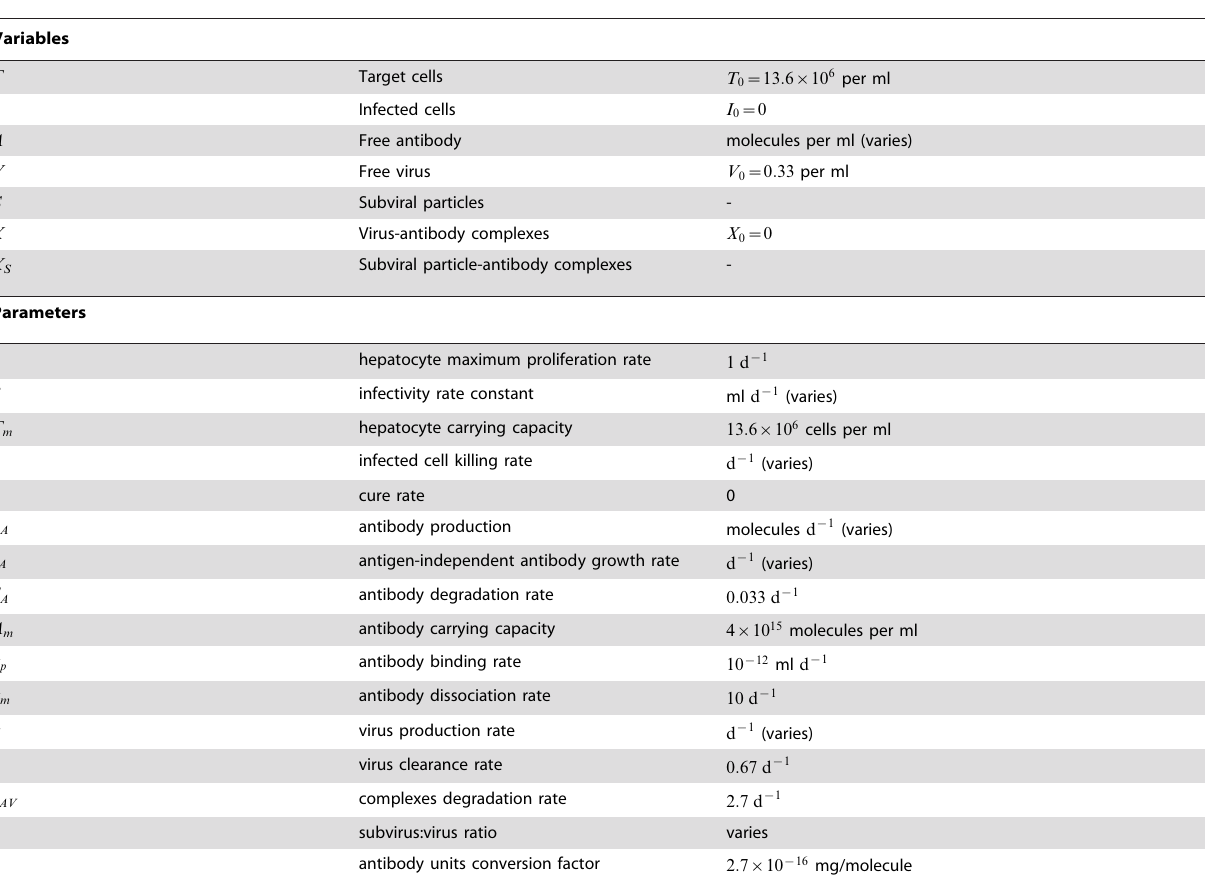
Table 1. Variables, parameters and values used in simulations.